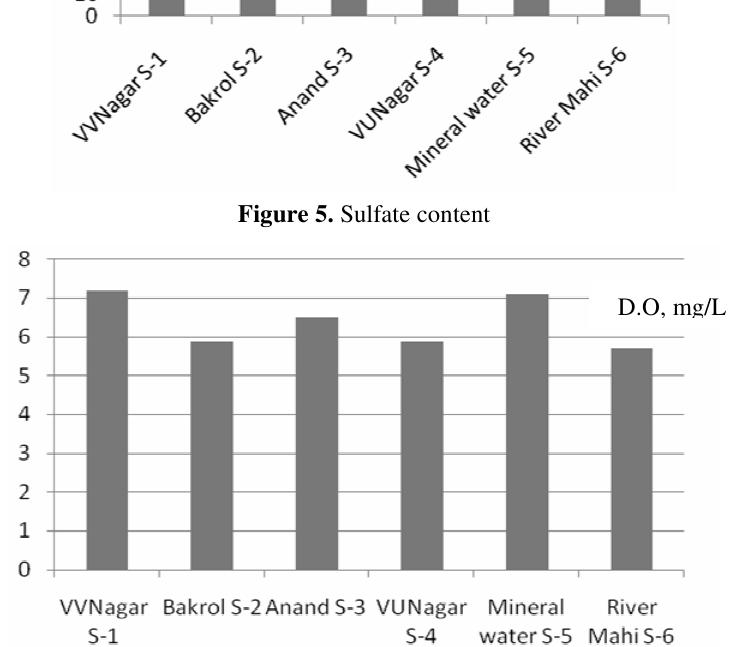
Figure 6. Dissolved Oxygen (DO).